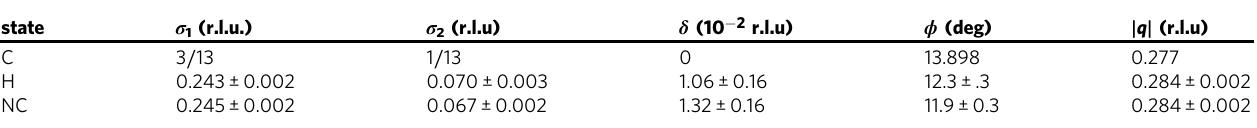
For all three states the superlattice peak widths within the plane are always comparable with the width of the Bragg peaks, which indicates that the in-plane superstructure remains long-range ordered. Note that the XRD data for the HCDW has been taken several seconds after the laser pulse hit the sample, which means that the sample temperature is well-de fi ned at T = 4 K. The fact that the CCDW would be the thermodynamic stable state under these conditions points to the metastable nature of the HCDW. shows that the non-equilibrium process driven by the 1.6 ps laser